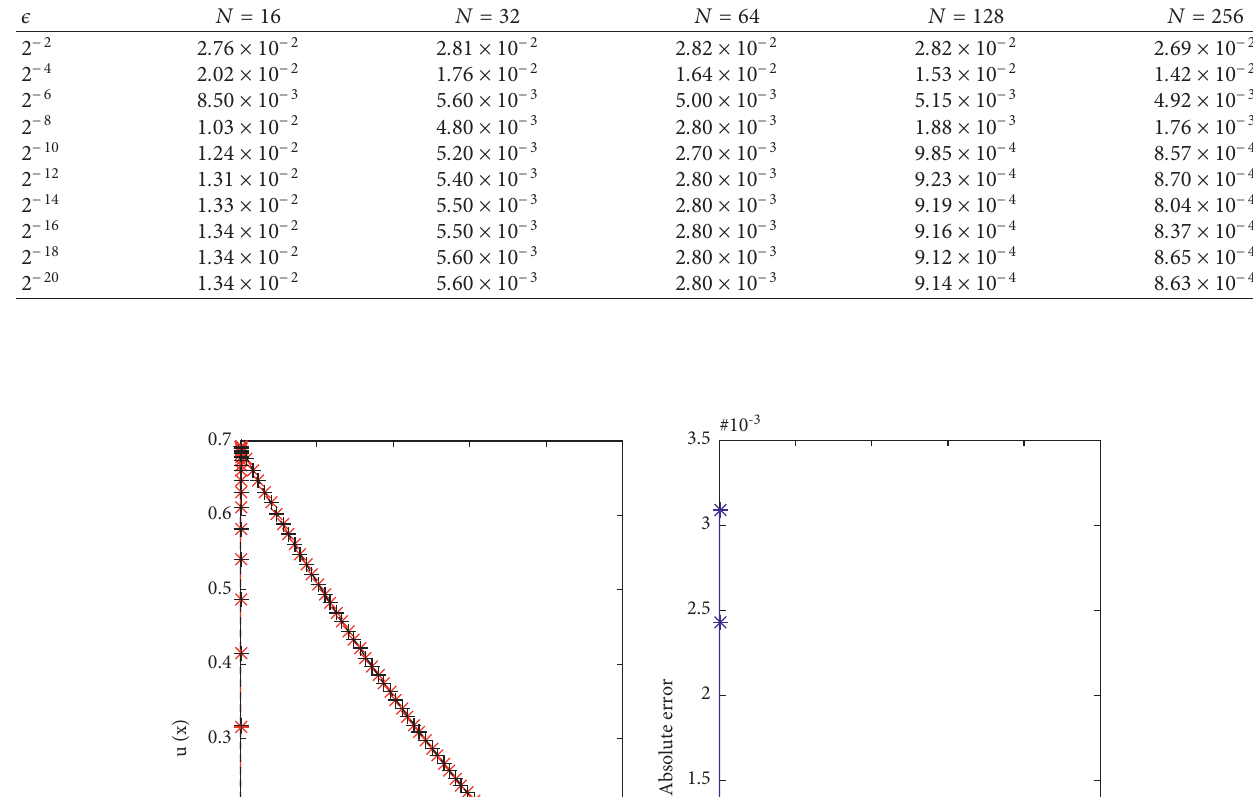
Table 11: L errors for Example 3 for different values of ϵ . ∞